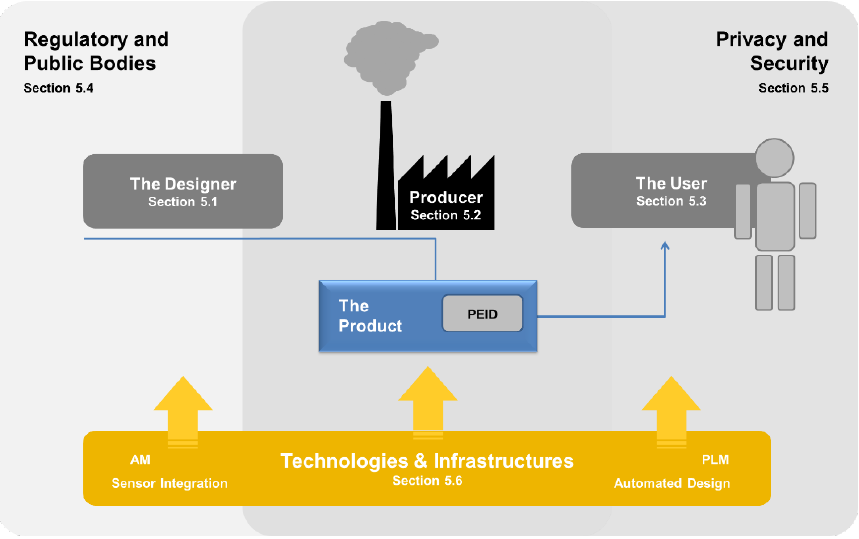
Figure 13. The main stakeholders and perspectives and their relation to each other.